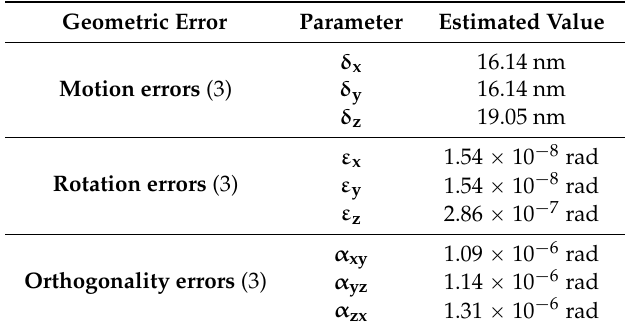
Table 4. Final contribution of the individual considered errors components ( ∆ T = ±0.1 °C): motion, rotation and orthogonality errors.